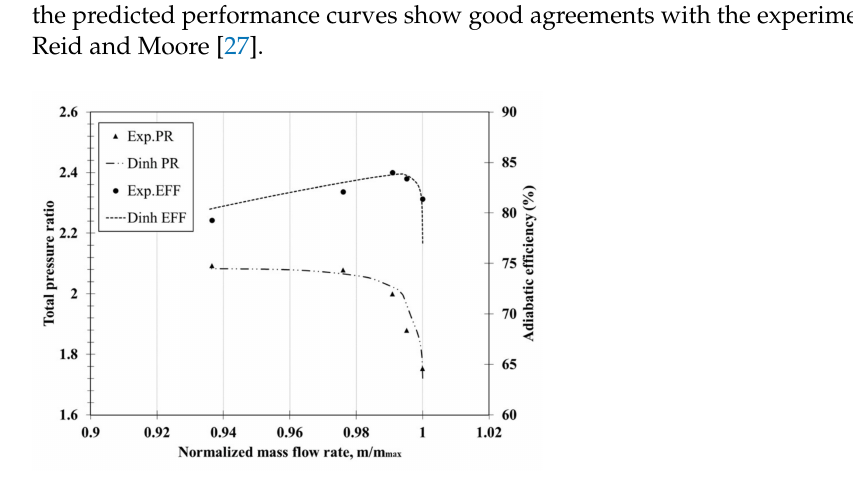
Figure 3. Validation of numerical results for NASA Stage 37 (Reprinted from ref. [29]. Copyright 2017 American Society of Mechanical